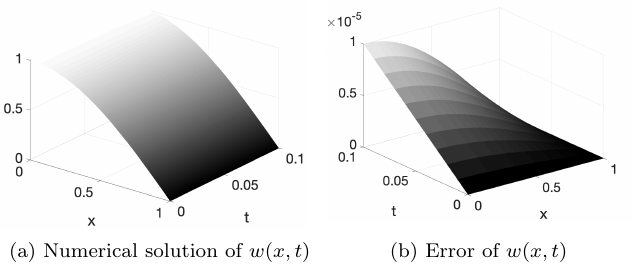
Figure 2. Numerical solution and the error of w ( x,t ) for ( x,t ) ∈ [0 , 1] × [0 ,T ] in example 1. α = 1 . 9, T = 0 . 1 and ∆t = 10 − 4 are used.